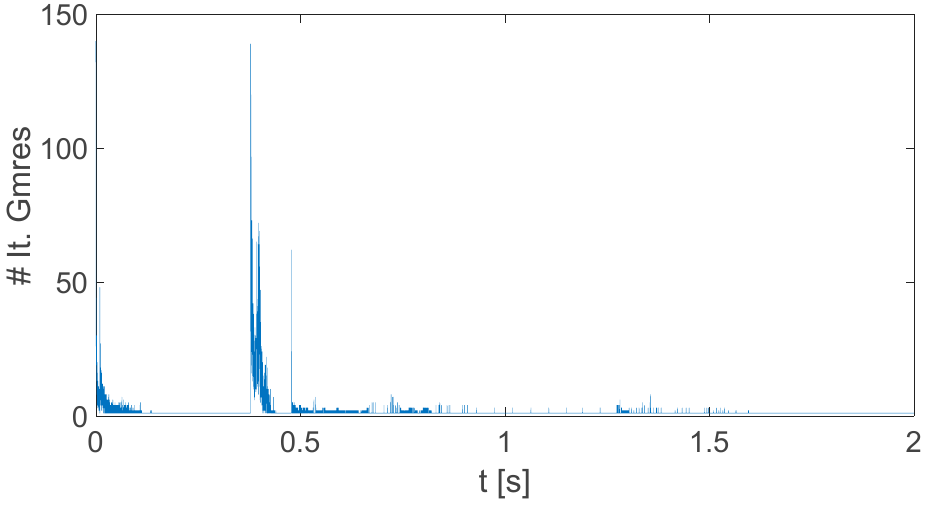
Figure 19. Testcase#2. The number of iterations required by GMRES to converge to a relative tolerance is 1 × 10 − 5 , versus time.